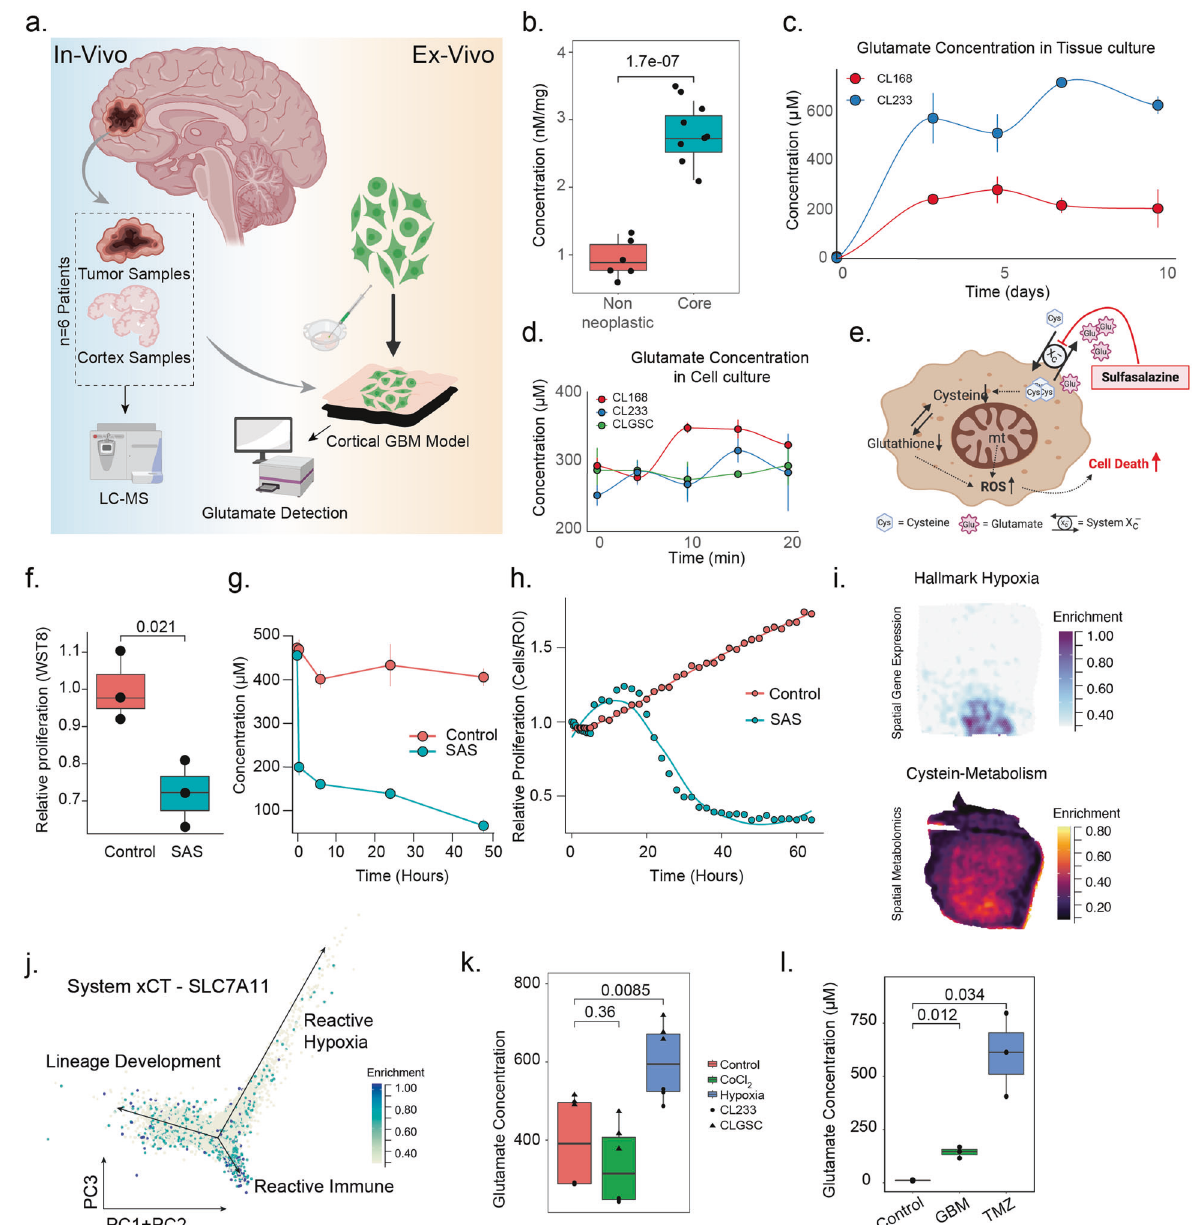
Fig. 1 Glutamate dynamics in GBM. a Work fl ow of the experimental paradigm used to study glutamate concentration within a GBM microenvironment. b Mass Spectroscopy based measurements of glutamate concentration from tissue samples sourced from the tumor core vs non in fi ltrated tissue show a signi fi cantly higher concentration of glutamate in the core ( n = 6 samples, p < 0.001, t test). c Healthy cortical tissue was inoculated with GBM cells and cultured over a period of 9 days. The growth medium was collected over the culture period and the glutamate concentration was quanti fi ed over a time period of 9 days. d Glutamate concentration in cell culture reaches a plateau within 1 min of medium swap. The maximum concentration is reached within 10 mins, which then maintained over the measurement period. e Mechanism of action of sulfasalazine, where the inhibition of the Glutamate-Cysteine transporter leads to an increase in ROS within the cells, leading to cell death. f Sulfasalazine treatment has a signi fi cant impact on Proliferation, as measured by WST-8 proliferation assay ( n = 3, p = 0.021). g Inhibition of the Glutamate/Cysteine symporter by means of Sulfazalazine (500 μ M) results in a signi fi cant reduction in the extracellular glutamate concentration over 48 h. h Relative proliferation of cells treated with SAS shows a signi fi cant decrease in comparison to control cells. i Spatially resolved expression pro fi le of Hypoxic regions shows an overlap with spatially resolved metabolomics of cysteine metabolism. j Expression of SLC7A11 within GBM samples show an enrichment within reactive hypoxia subtype of GBM. k Exposure of GBM to hypoxic conditions result in a signi fi cant increase in glutamate concentration ( n = 3, p = 0.0085). This increase in glutamate concentration was not observed in arti fi cial hypoxia, by CoCl 2 ( n = 3, p = 0.36). l Glutamate concentration measurements from tissue culture experiments where cortical sections were inoculated with GBM shows a signi fi cant increase in comparison to control sections ( n = 3, p = 0.012). When the sections were further treated with TMZ, a signi fi cant increase in glutamate concentration was seen with respect to control sections ( n = 3, p = 0.034). All box plots represent median, with hinges representing 25th and 75th percentile and whiskers representing 1.5x Interquartile range.